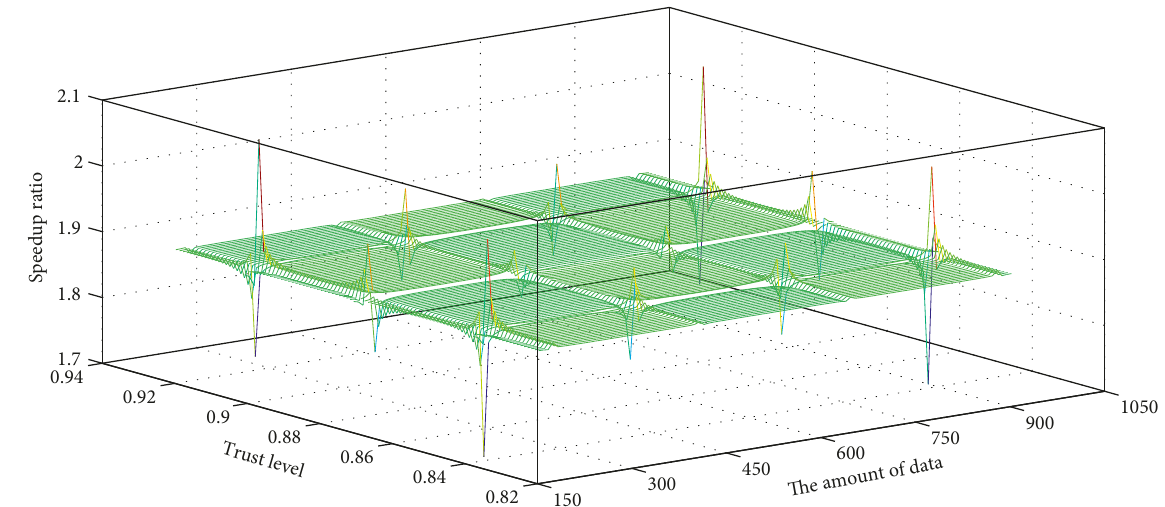
Figure 5: Speedup of the